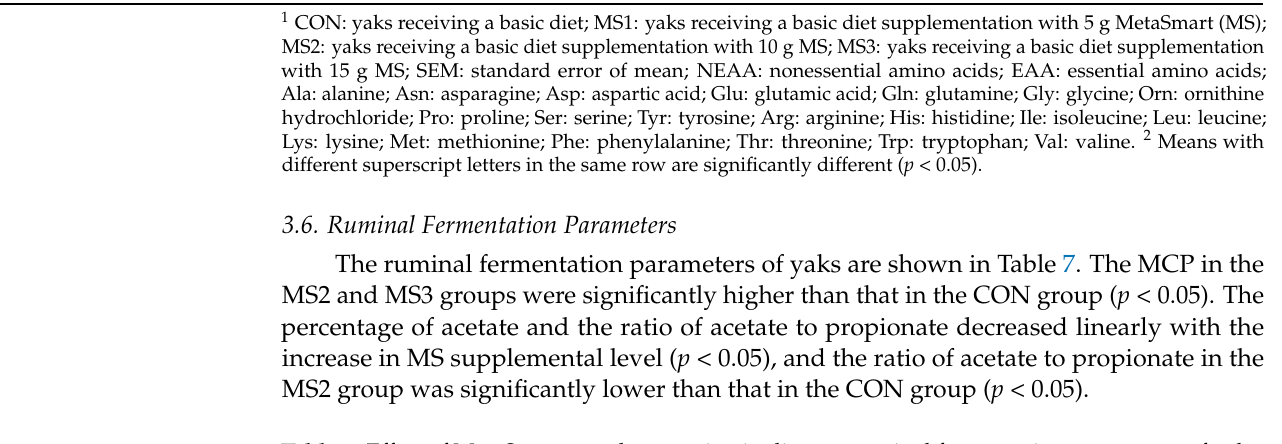
Table 7. Effect of MetaSmart supplementation in diets on ruminal fermentation parameters of